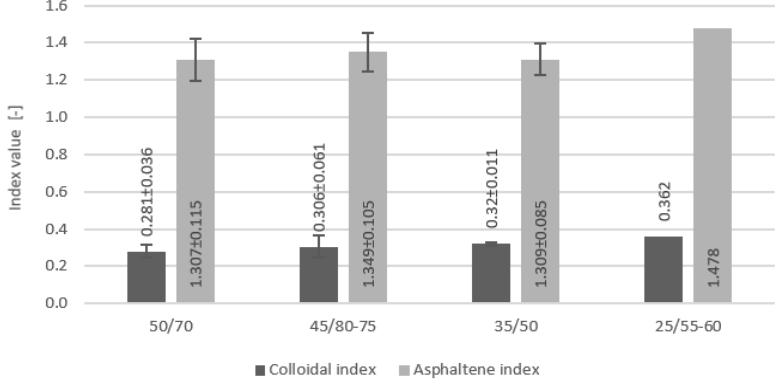
Figure 4. Composition indexes I A and I C on the base of SARA fractions of tested bitumen samples.